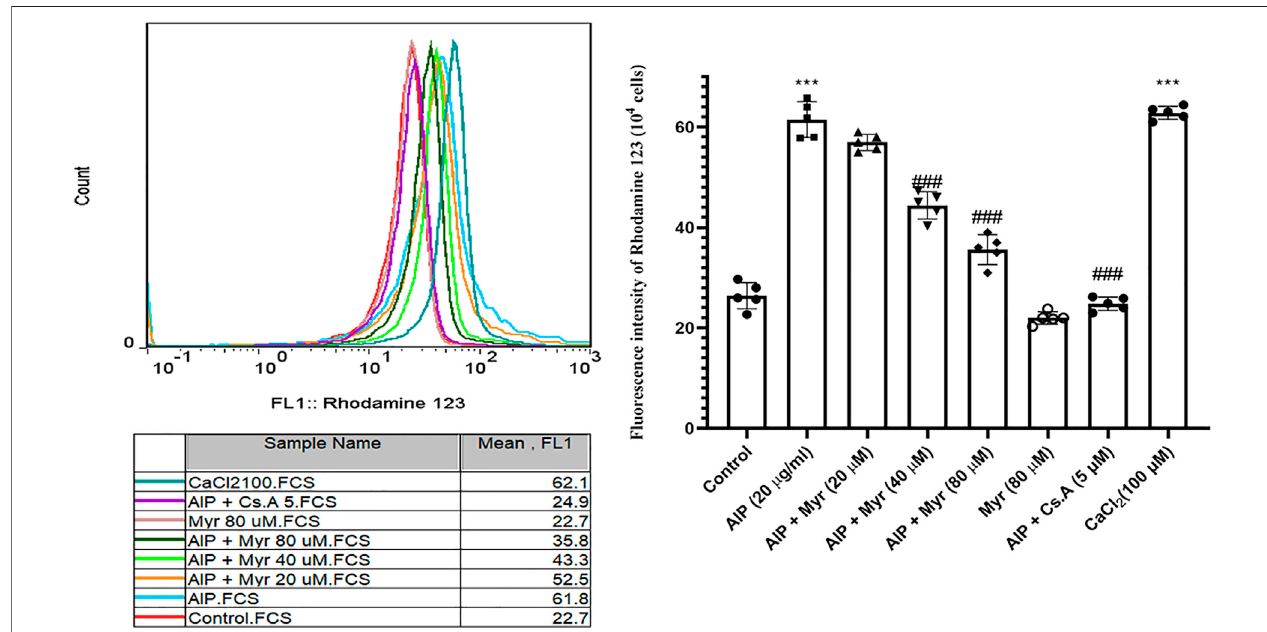
FIGURE 3 | Myr inhibits AlP-induced mitochondrial membrane potential ( ΔΨ m) collapse in isolated cardiomyocytes. Isolated cardiomyocytes were treated or cotreatedwiththeindicatedconcentrations(20 μ g/ml)ofAlPandMyr(20,40,and80 µM)for3 h.Mitochondrialmembranepotential( ΔΨ m)collapsewasexaminedafter incubation using rhodamine 123 staining. Representative fl uorescence intensity of rhodamine 123 staining. Data presented are the mean ± SD ( n (cid:2) 3 per group). *** p < 0.001comparedwithcontrol;## p < 0.01;### p < 0.001comparedwithAlP-treatedcardiomyocytes,one-wayANOVA,Tukey ’ stest.Myr,myricetin;AlP,aluminum phosphide; Cs.A, cyclosporine; CaCl ₂ , calcium chloride.